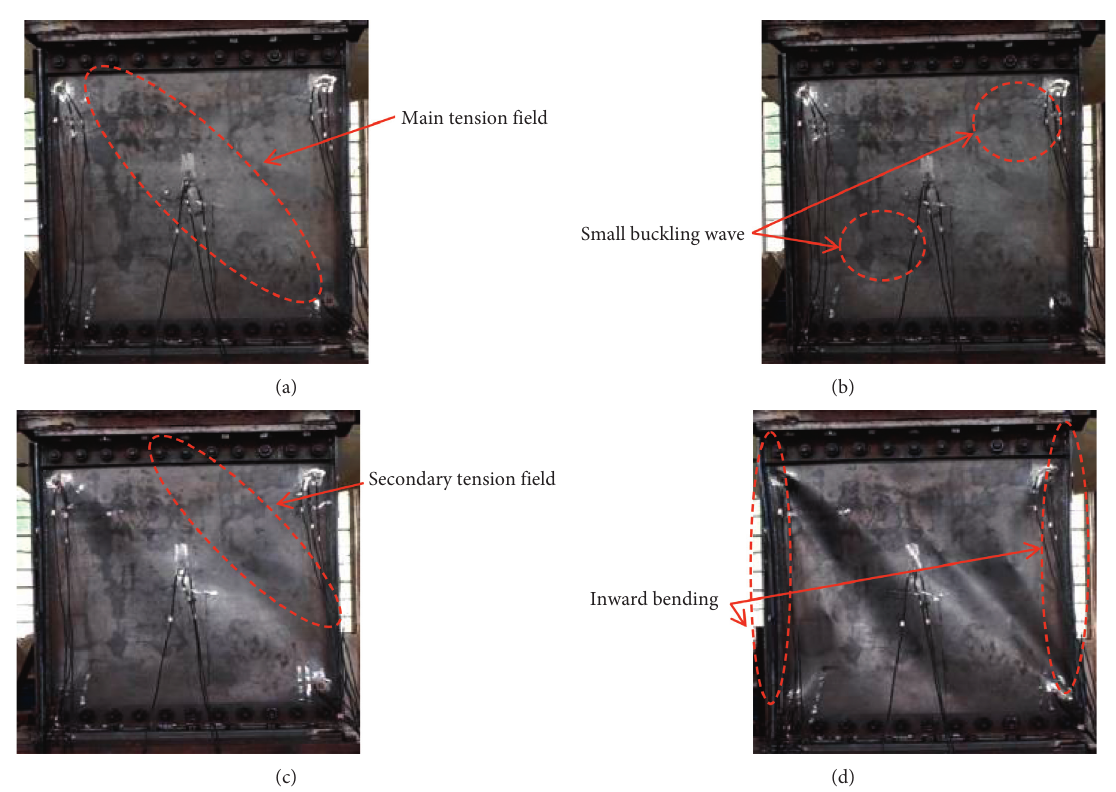
Figure 11: Deformation of SPSW specimen under different loading displacements. (a) 2mm. (b) 8mm. (c) 24 mm. (d)